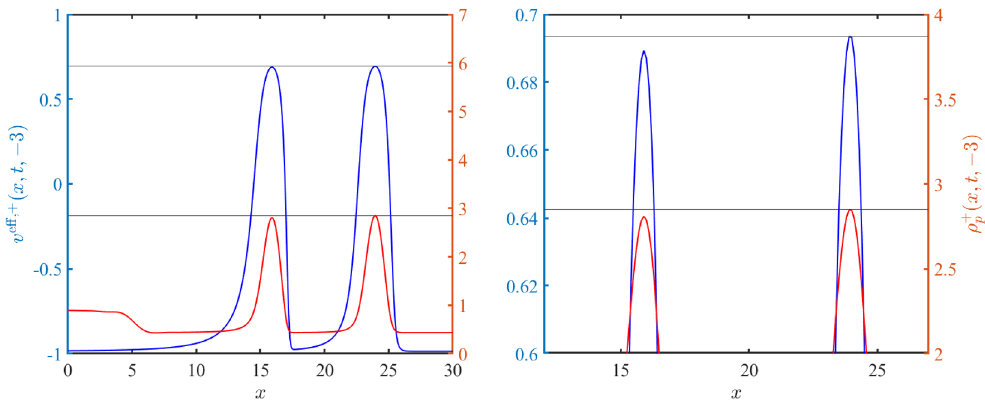
Figure 19 . Spectral density (red) and effective velocity (blue) cuts for θ = − 3 and t = 20 . The right is a close-up of the left figure. The right subsidiary peak, which aligns with a larger magnet, is both larger and has a higher effective velocity than the left subsidiary peak, even if their propagation velocities are asymptotically the same. The parameters are α